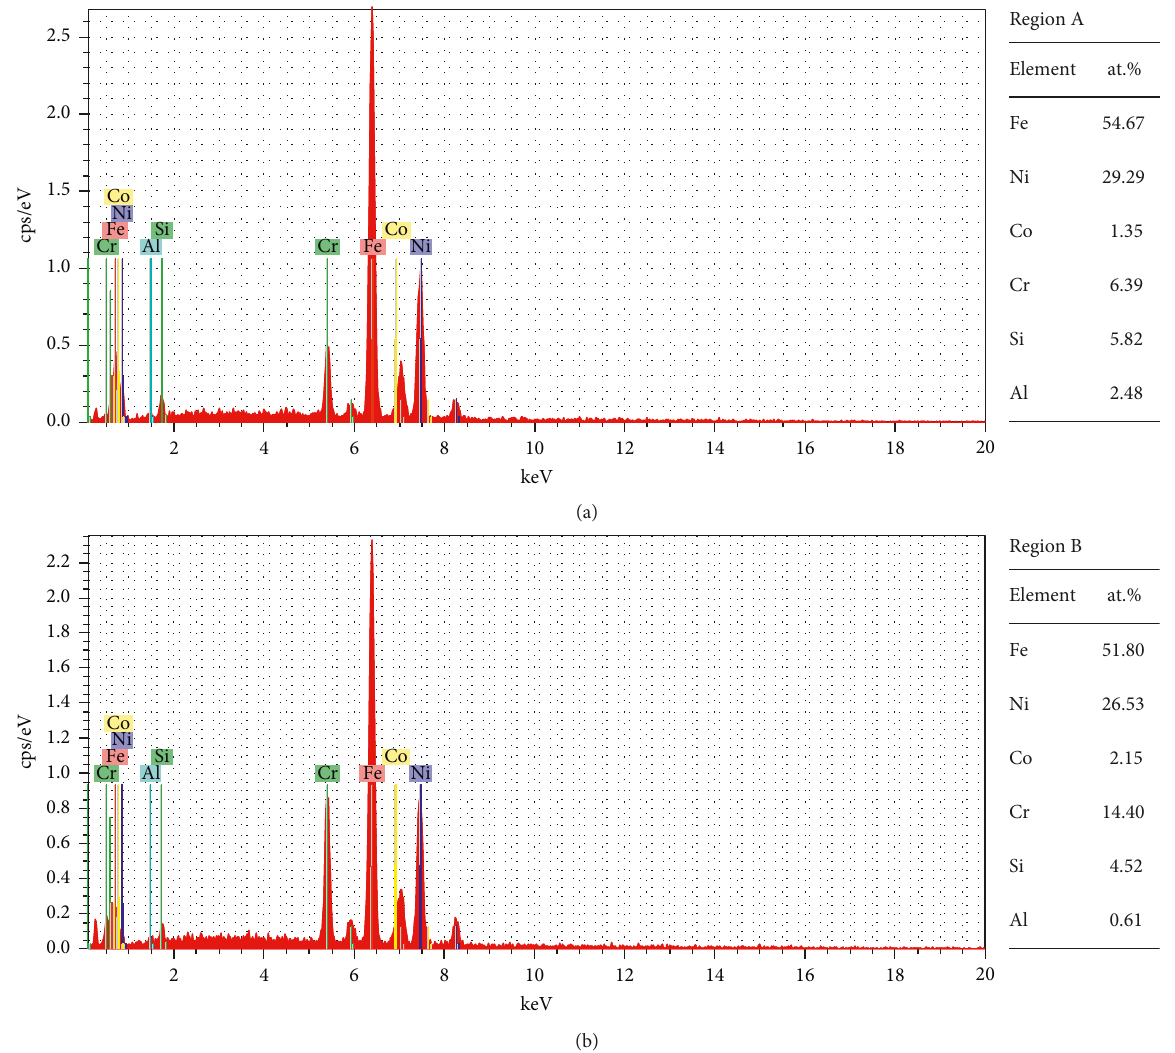
Figure 7: EDS results of dendritic and interdendritic region. (a) Region A and (b) region B.